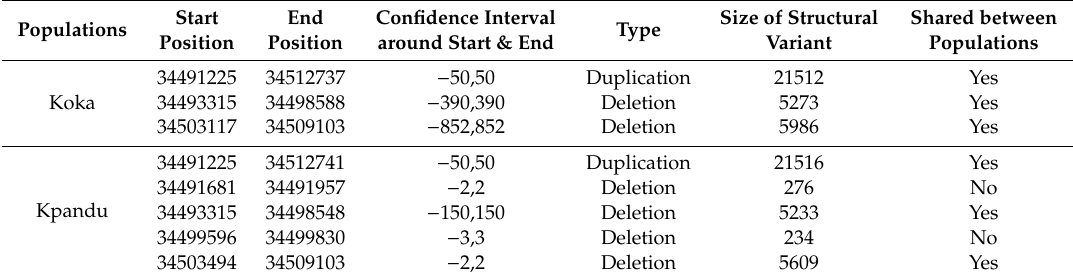
Table 3. Structural variants located in the oaz1-dot1l region of LG23 in wild populations of Nile tilapia found with DELLY on whole-genome sequencing